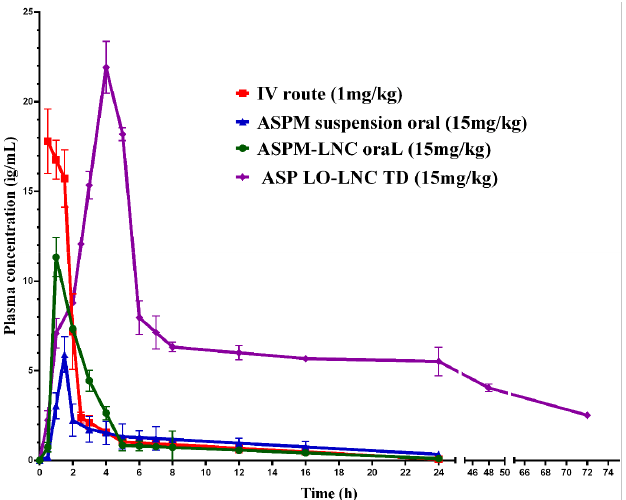
Figure 8. Plasma concentrations of asenapine after IV, oral and transdermal